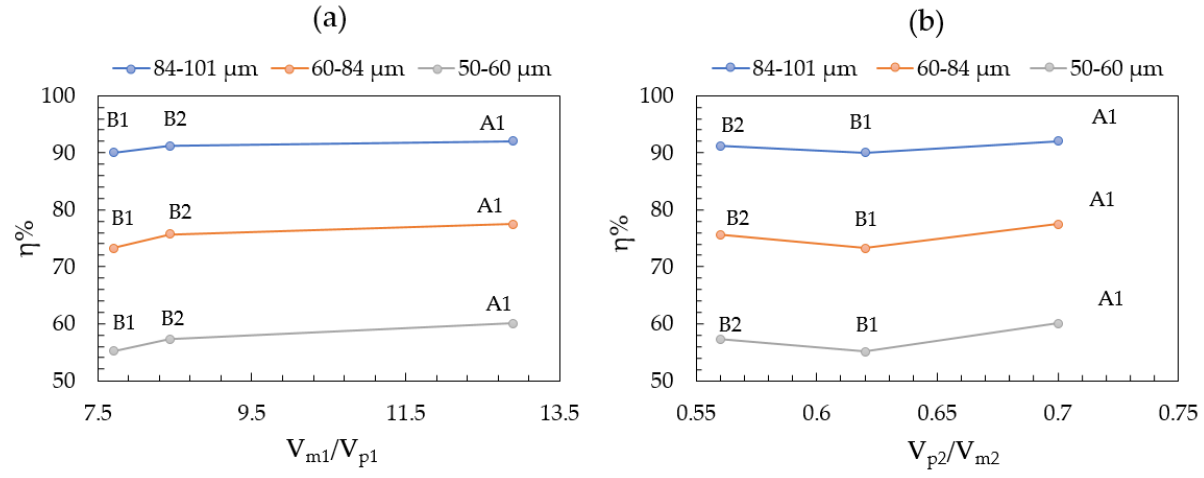
Figure 7. The relationship between ( a ) V m1 / V p1 in inlet tank and inclusion removal rate, and ( b ) V p2 / V m2 in outlet tank and inclusion removal rate for Case B1, B2 and A1. Table 8. Ratio between mixed flow and plug flow and inclusion removal rate of Cases B1, A1 and B2.